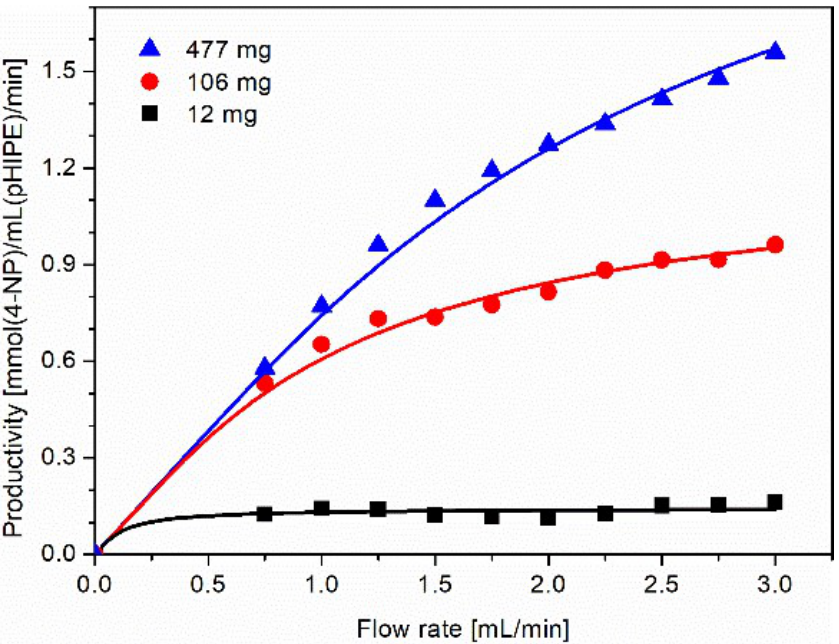
Figure 8. The productivity vs. mobile phase flow rate according to Equation (5). Reaction conditions and details are described in Section